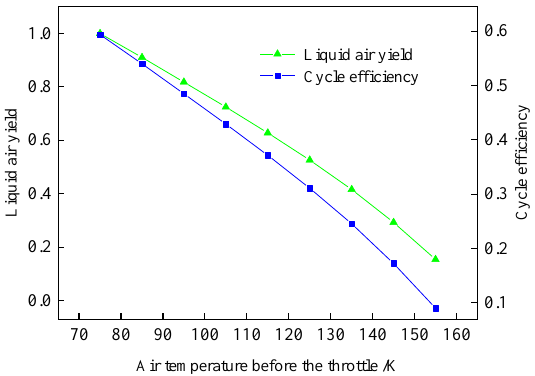
Figure 6. Influence of temperature before air throttling on liquid air yield ratio and cycle efficiency.